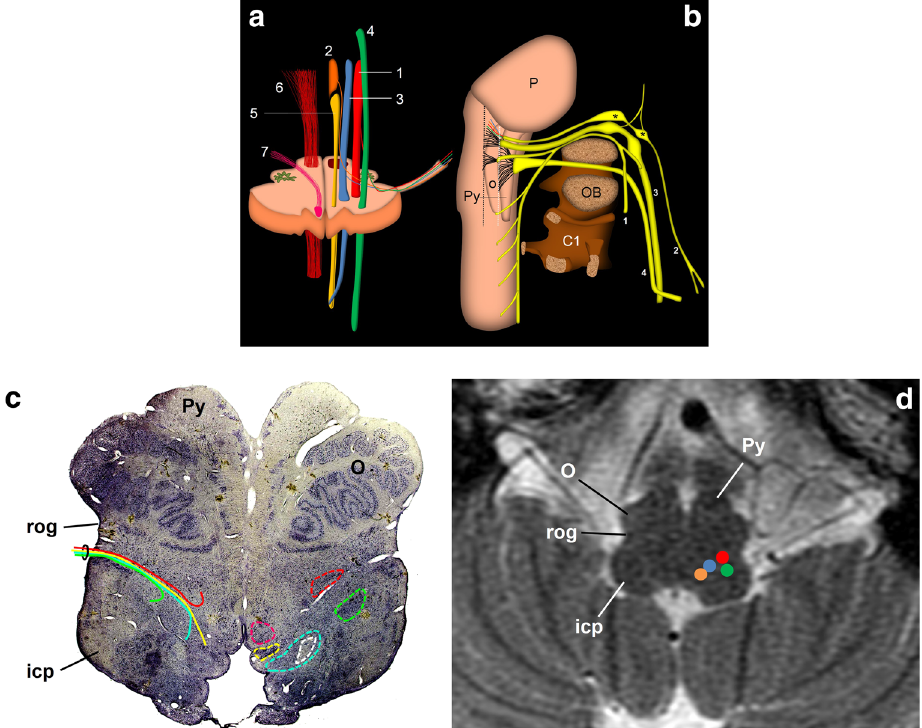
Fig. 1 Schematic representation of the glossopharyngeal nerve. a Transversal section of the medulla oblongata at the level of the inferior olivary nucleus. Efferent nuclei: nucleus ambiguous (1) and inferior salivatory nucleus (2); afferent nuclei: solitary nucleus (3) and sensitive trigeminal nucleus (4). Other relevant structures: dorsal motor nucleus of the vagus nerve (5), pyramidal tract (6) and hypoglossal nerve (7). b Schematic drawing of the lower cranial nerves representing their mutual relationships and course from the brain stem to the cranial exit. 1: spinal nerve; 2: glossopharyngeal nerve; 3: vagus nerve; 4: hypoglossal nerve; P: pons; O: inferior olivary nucleus; Py: pyramid; C1: atlas; OB: occipital bone. The hypoglossal nerve exits the cranium through the anterior condylar canal; the glossopharyngeal, vagus and spinal nerves exit the cranium along the jugular foramen. *Glossopharyngeal nerve nodes;